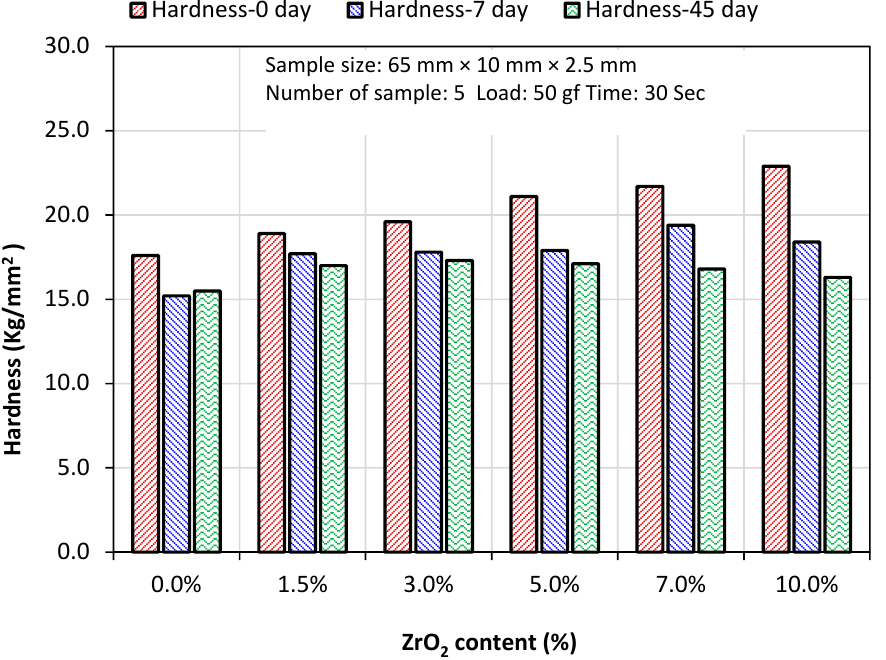
Figure 3. Vickers hardness median (kg/mm 2 ) after 0, 7, and 45 days of water immersion. Table 3. Vickers hardness (kg/mm 2 ) (median and interquartile range) after 0, 7 and 45 days of water immersion.